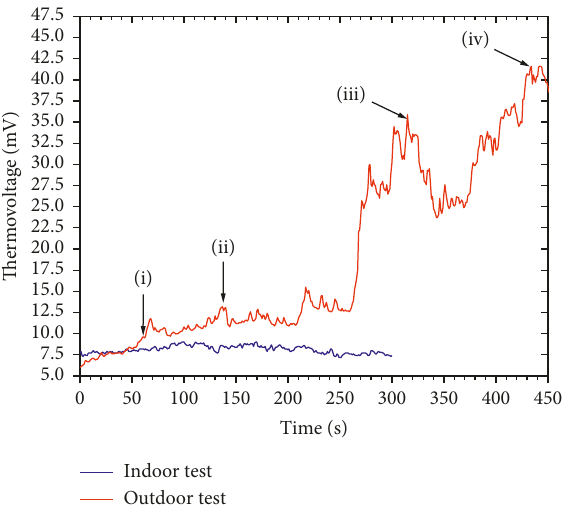
Figure 4: Indoor / outdoor testsshowthermoelectricresponsesofthermocellunderroomtemperatureandheatingwithheatsourceinrealconditions.